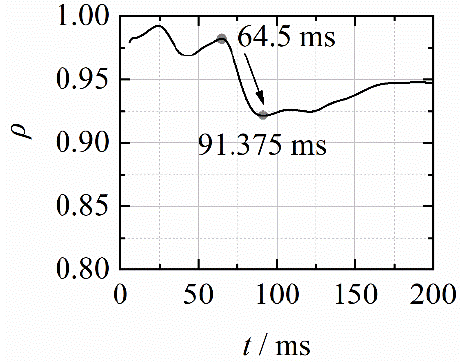
Figure 11. Linear correlation ρ of E ( t ) and E ’ ( t ).